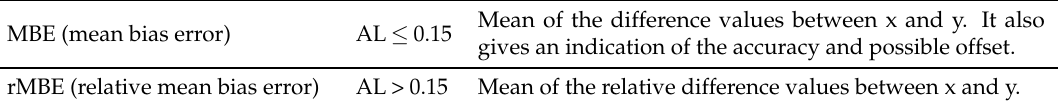
Table 6. Uncertainty metrics to assess the